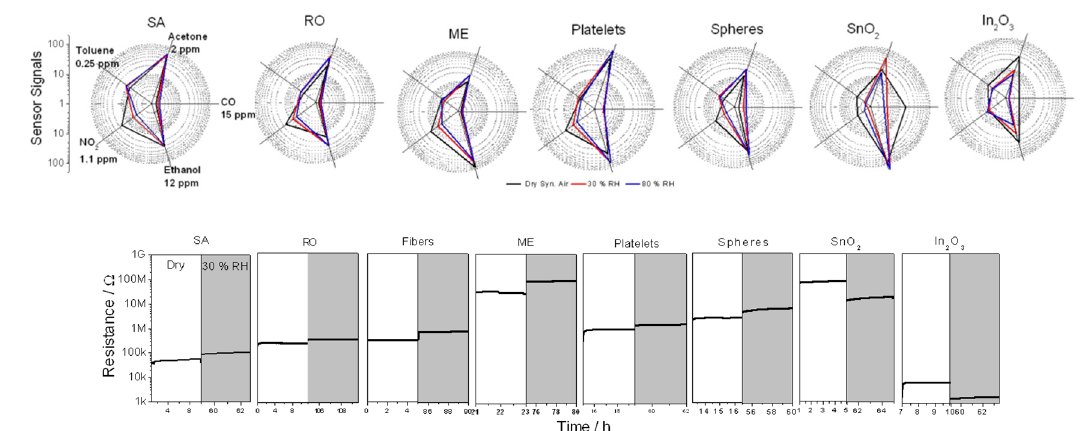
Figure 3. ( Top ) The sensor signal calculated based on the DC resistance measurements ( in the case of reducing gases the resistance in air was divided by that during gas exposure, while for oxidizing gases the inverse relationship was used). ( Bottom ) The baseline resistance is shown of the sensors in dry air and in 30 %RH.